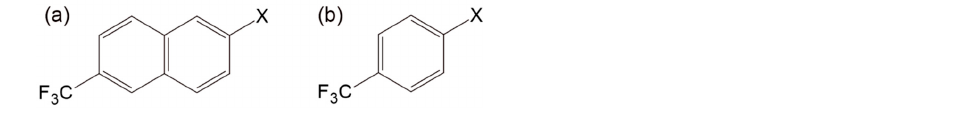
Figure 2. Similarity of 6 ‐ trifluoromethyl ‐ 2 ‐ X ‐ naphthalene 2 ‐ 6 ( a ) and p ‐ trifluoromethyl ‐ X ‐ benzene X ‐ ( p ‐ Ph) ‐ CF 3 ( b ).